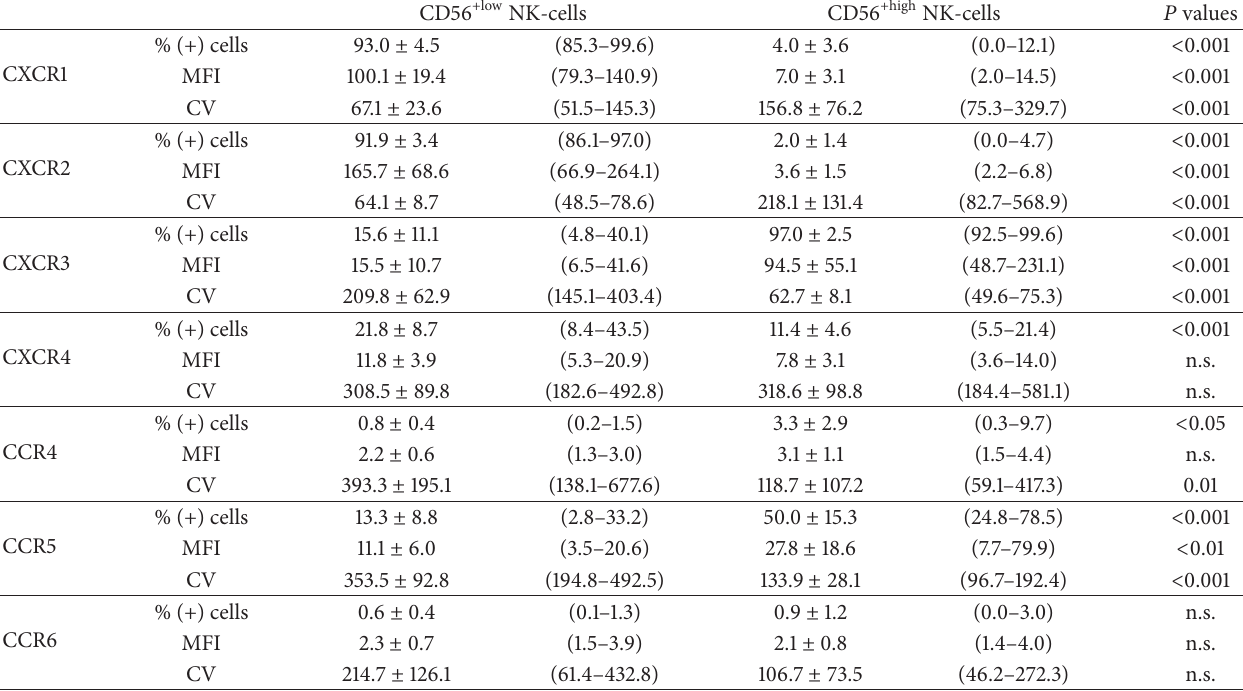
Table 1: Chemokine receptor expression on the well-known CD56 +low and CD56 +high NK-cells observed in blood, as identified based only on the levels of CD56 and CD16